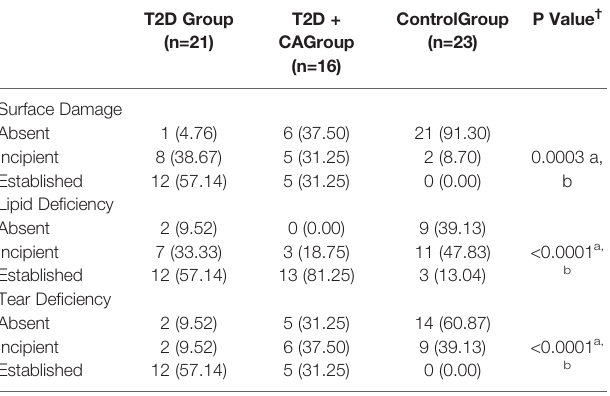
TABLE 4 | Comparison of Ocular surface dysfunction between type 2 diabetes (T2D) patients with Charcot arthropathy (CA), T2D patients without CA, and healthy